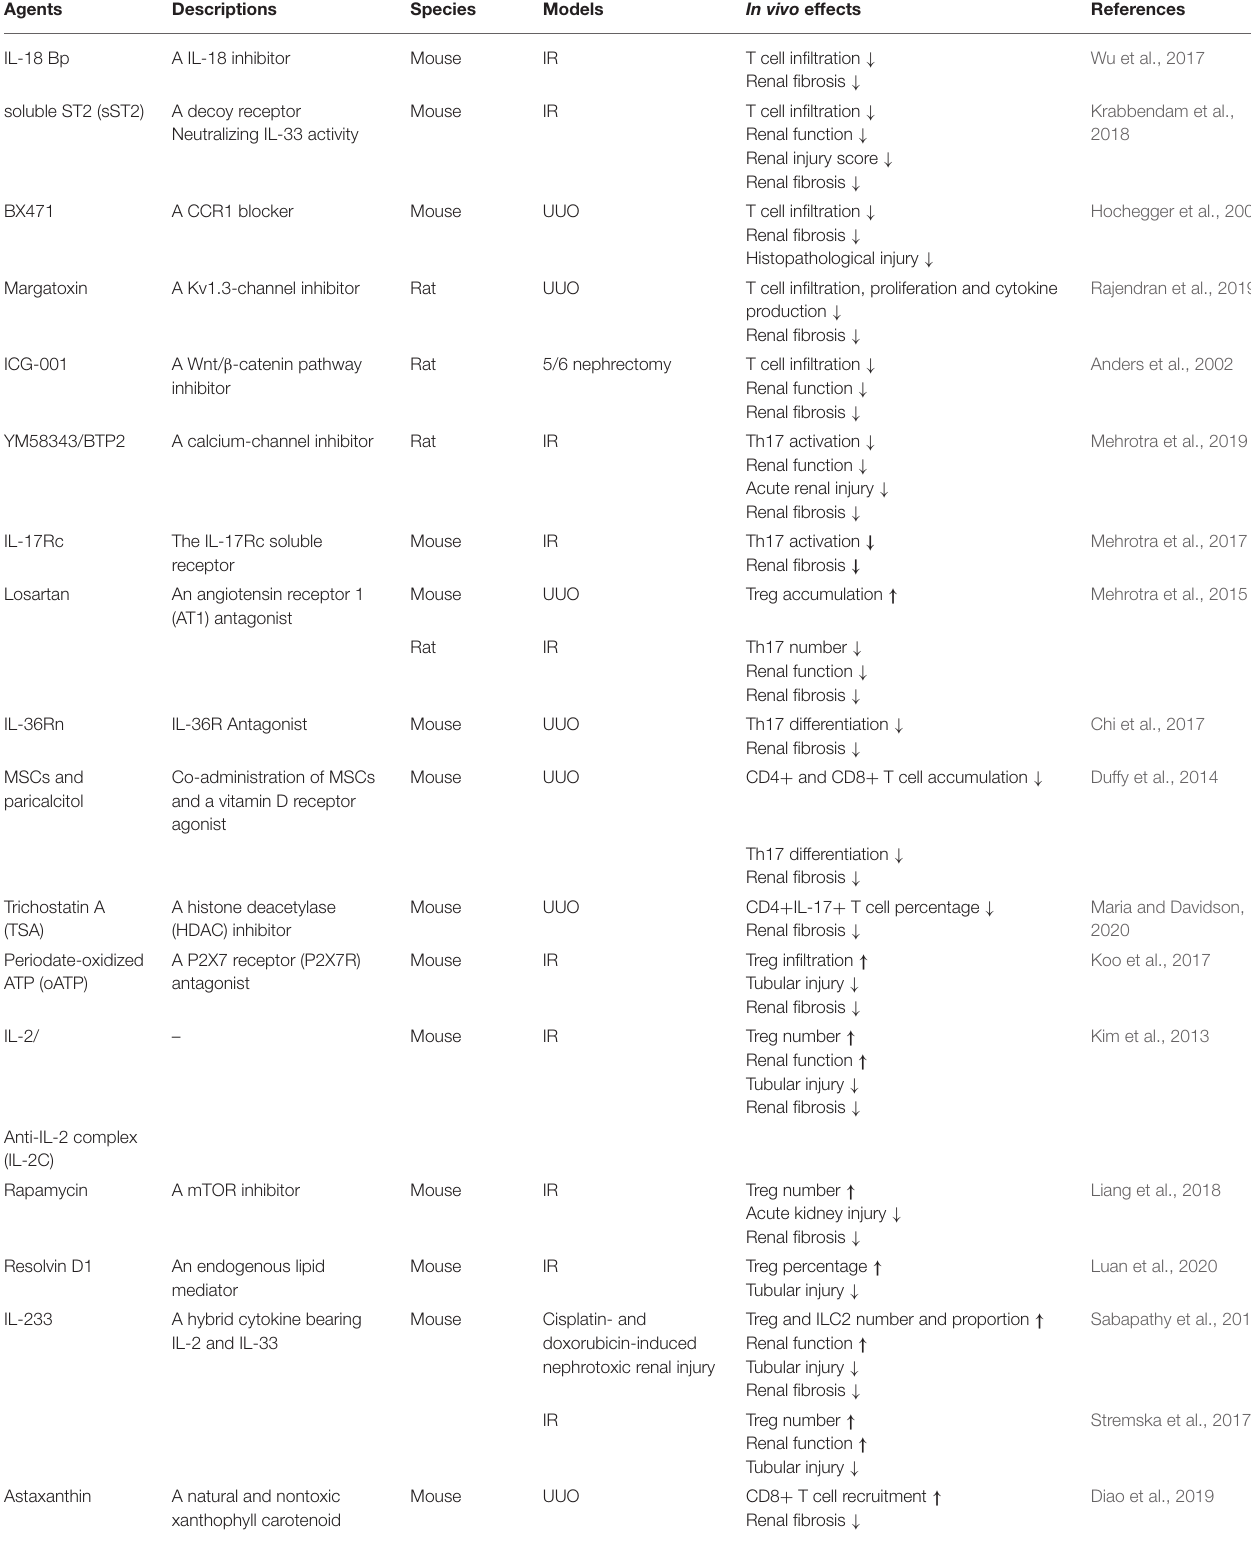
TABLE 3 | The treatments targeting of lymphocytes in vivo